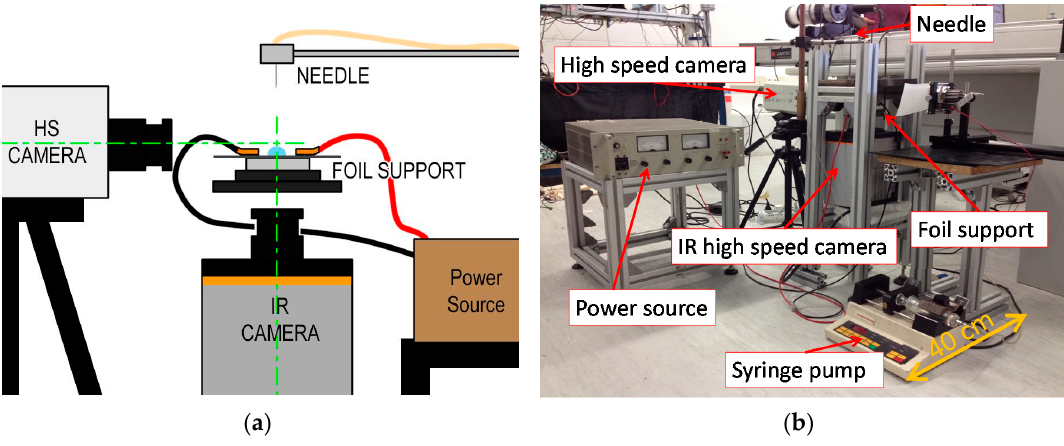
Figure 1. ( a ) Schematic view and ( b ) photograph of the experimental set up used in the present work.